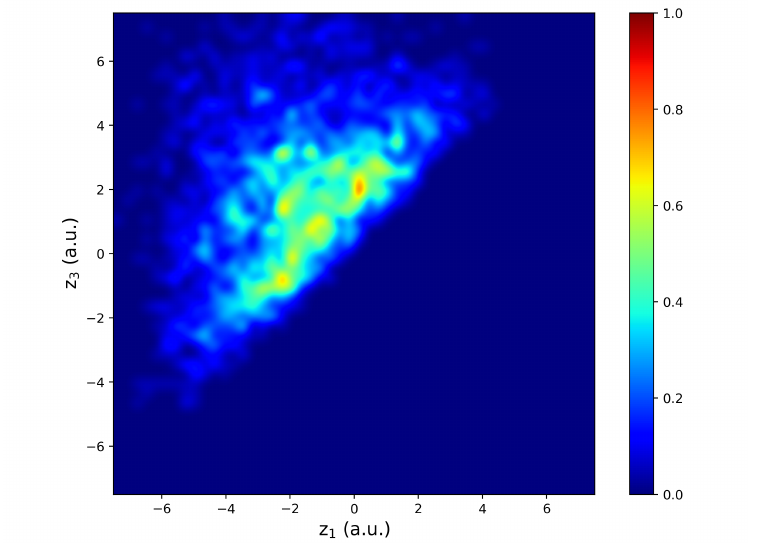
Figure 7. Normalized contour plot for the projectile z coordinate value at the moment in which the third electron is emitted (z 3 ) as a function of the z coordinate value at the moment in which the first electron is emitted (z 1